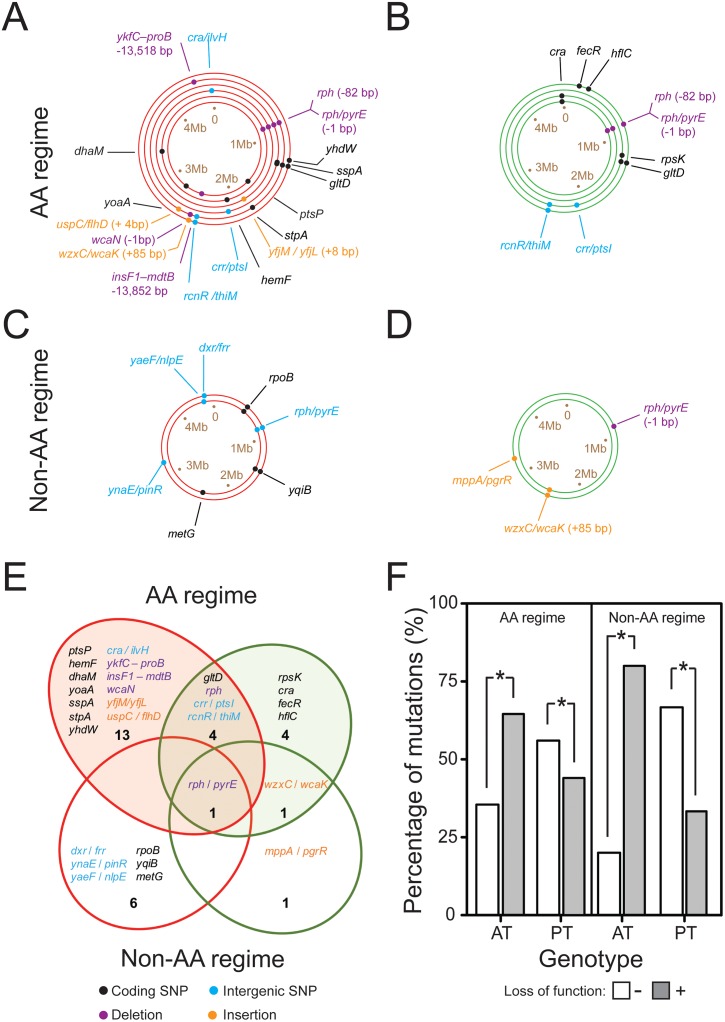
Genomic consequences of adaptation to the two selection regimes.Auxotrophic and prototrophic genotypes that evolved in the two regimes harbor distinct mutations. (A-D) Each ring represents the genome of a single auxotrophic (red rings) or prototrophic (green rings) clone that has been isolated from different replicate populations, which have evolved (A,B) for 2,000 generations under AA-replete, or (C,D) for 1,500 generations under AA-deficient conditions. The order of rings represents the replicate populations from which the cognate auxotroph and prototroph have been isolated. Dots indicate the relative position of the identified mutations within the genome with different colors specifying the type of mutation (see legend). Please see S2 Table for abbreviations of gene names and S3 Table for the identity of genotypes. SNP = single nucleotide polymorphism. (E) Venn diagram summarizing the mutations, which are unique to either auxotrophs (red ellipses) or prototrophs (green ellipses) and those that are shared between both types (overlapping region) for the strains isolated from the AA regime (top, filled ellipses) and non-AA regime (bottom, unfilled ellipses). Numbers indicate the total number of mutations in each sector. Mutations are colored according to their type (see legend). (F) The percentage of mutations present in auxotrophic (AT) or prototrophic (PT) genotypes isolated from the AA regime (left panel) or non-AA regime (right panel) that were predicted to cause a loss (grey bars) or no loss (open bars) in function. Asterisks indicate significant differences in the frequency of both mutation types between auxotrophic and prototrophic genotypes (Pearson’s chi square test: P<0.05, n≥6).